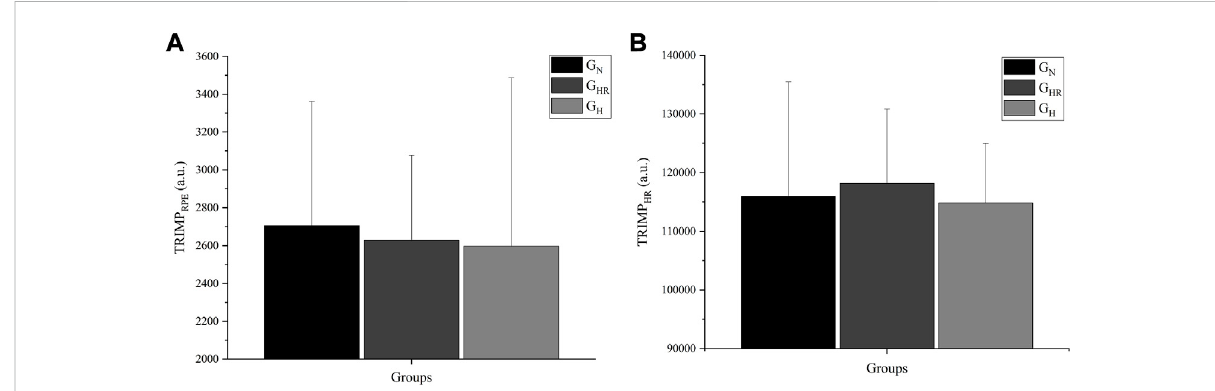
FIGURE 6 Mean TRIMP quanti fi ed by the rate of perceived exertion (RPE) (A) and heart rate (HR) (B) at the end of the 8-week intervention. G N = group in normoxia; G HR = group in hypoxia recovery; G H = group in hypoxia; TRIMP RPE = TRIMP quanti fi ed by RPE; TRIMP HR = TRIMP quanti fi ed by